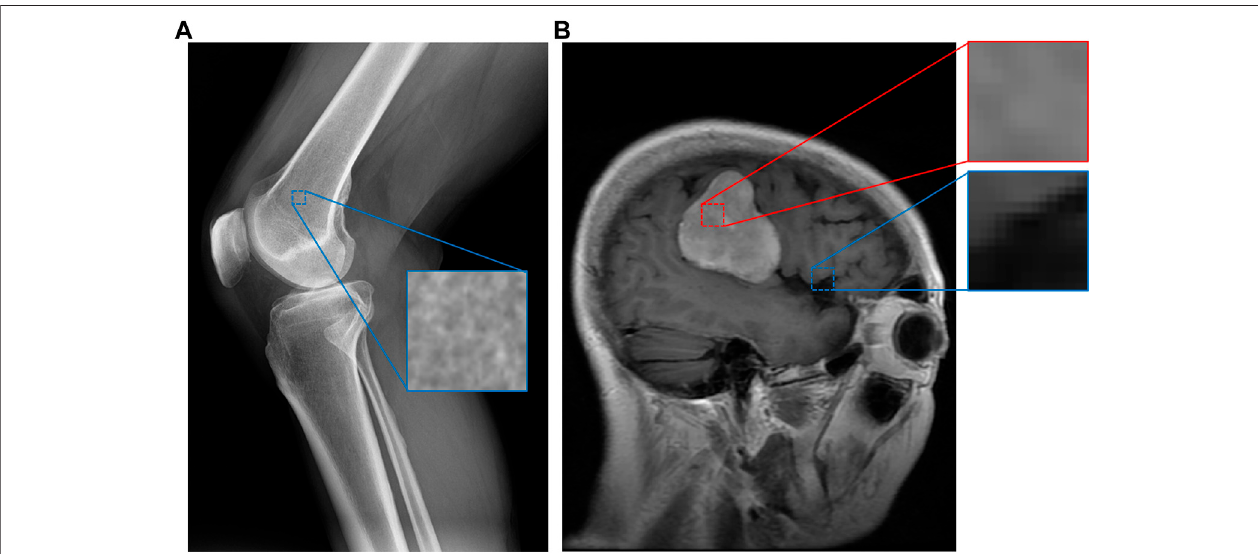
FIGURE 1 | An example of image patches taken from a knee X-ray (A) and a brain MRI with a tumor (B) (Cheng, 2017). Although some categories, such as bone, have apparent material distinctions, others such as tumor (in red) and healthy (in blue) brain tissue may not have obvious material differences. However, our system can still discern these differences since the images are expertly labeled, while assigning smaller perceptual distances (similarity) between pairs of categories more similar to each other.